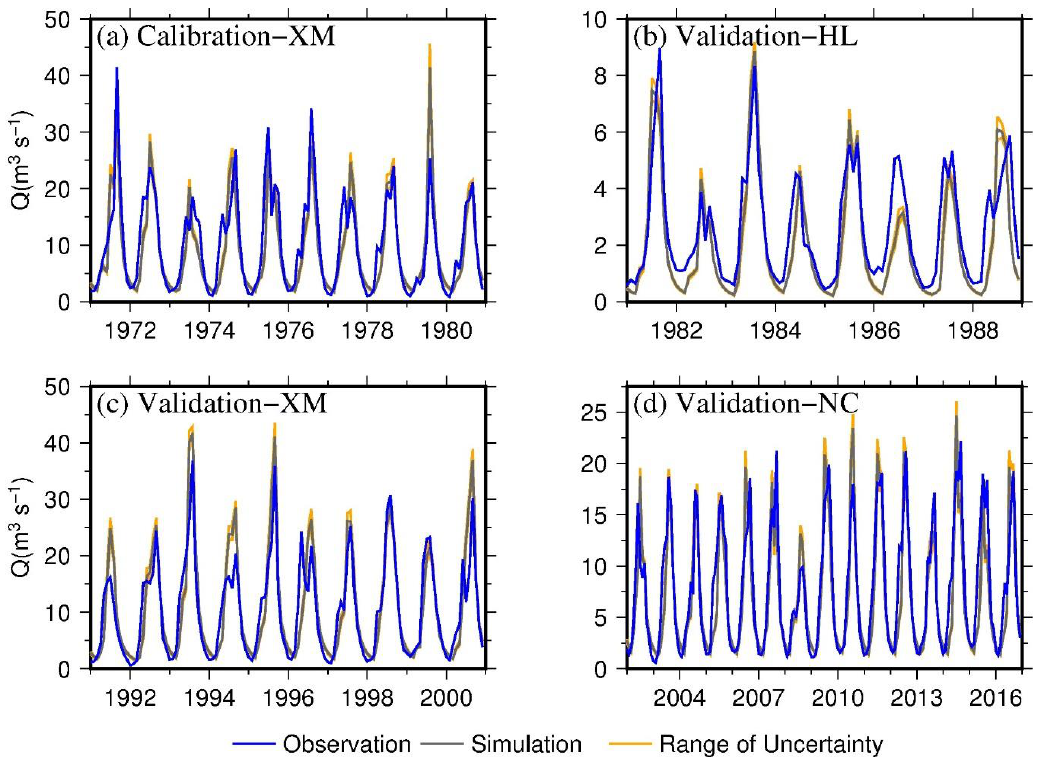
Figure 4. Monthly observed and simulated streamflow during calibration and validation periods at XM, HL, and NC hydrological stations. Orange lines represent the range of uncertainty resulted from parameter value uncertainty. Table 4. Statistics of daily peak flows and low flows selected from top 10 maximum flow and bottom 10 minimum flow in each year during calibration and validation.